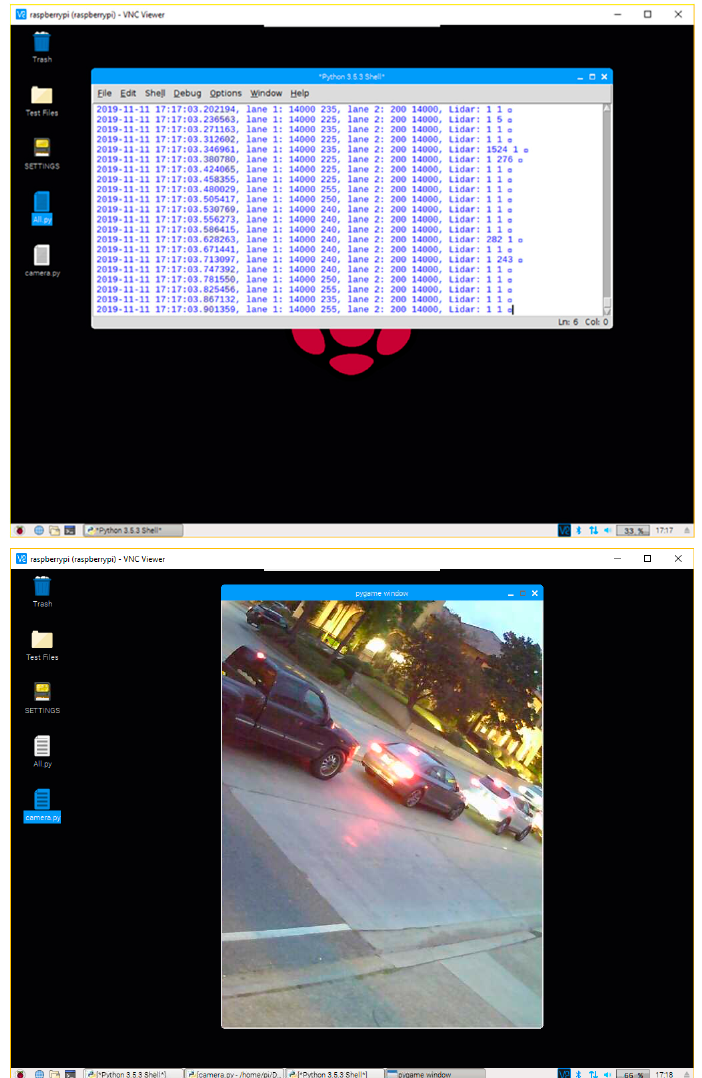
Figure 6. Remote connection to on-site computer desktop showing raw height and lane data ( top ) and live camera feed ( bottom ).